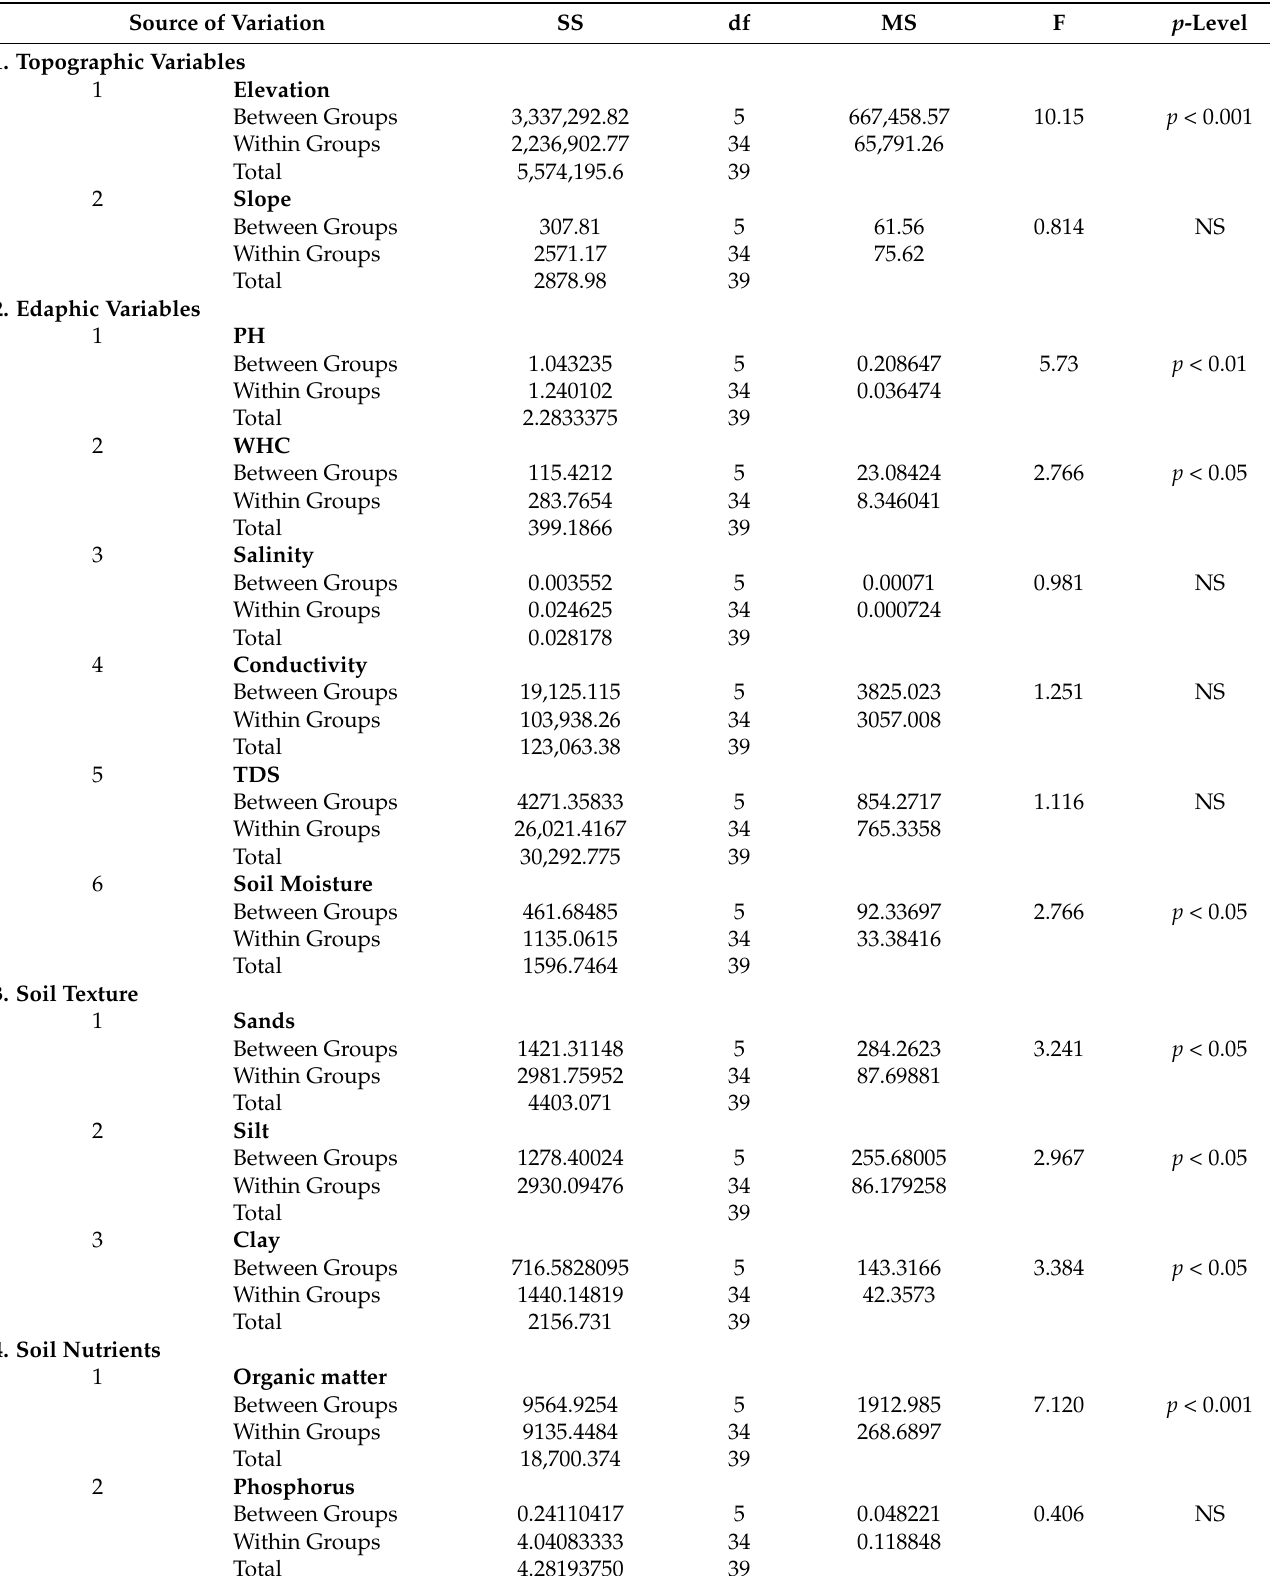
Table 3. Analysis of the variance of individual environmental variables (topographic, edaphic, soil texture, and soil nutrients) by Ward’s cluster analysis using the tree vegetation data of 40